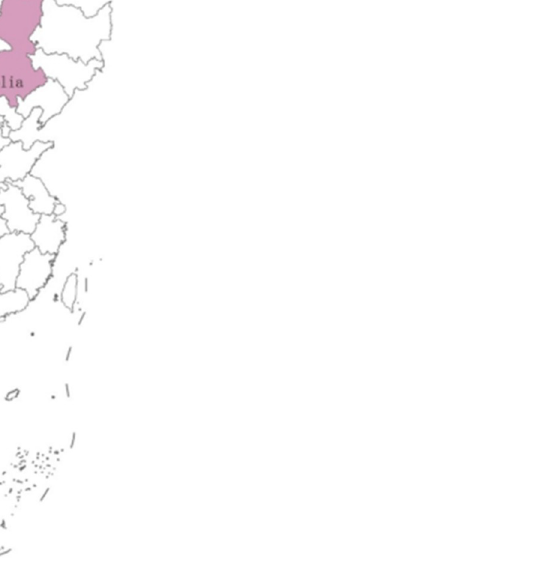
Fig 1. Research area of this